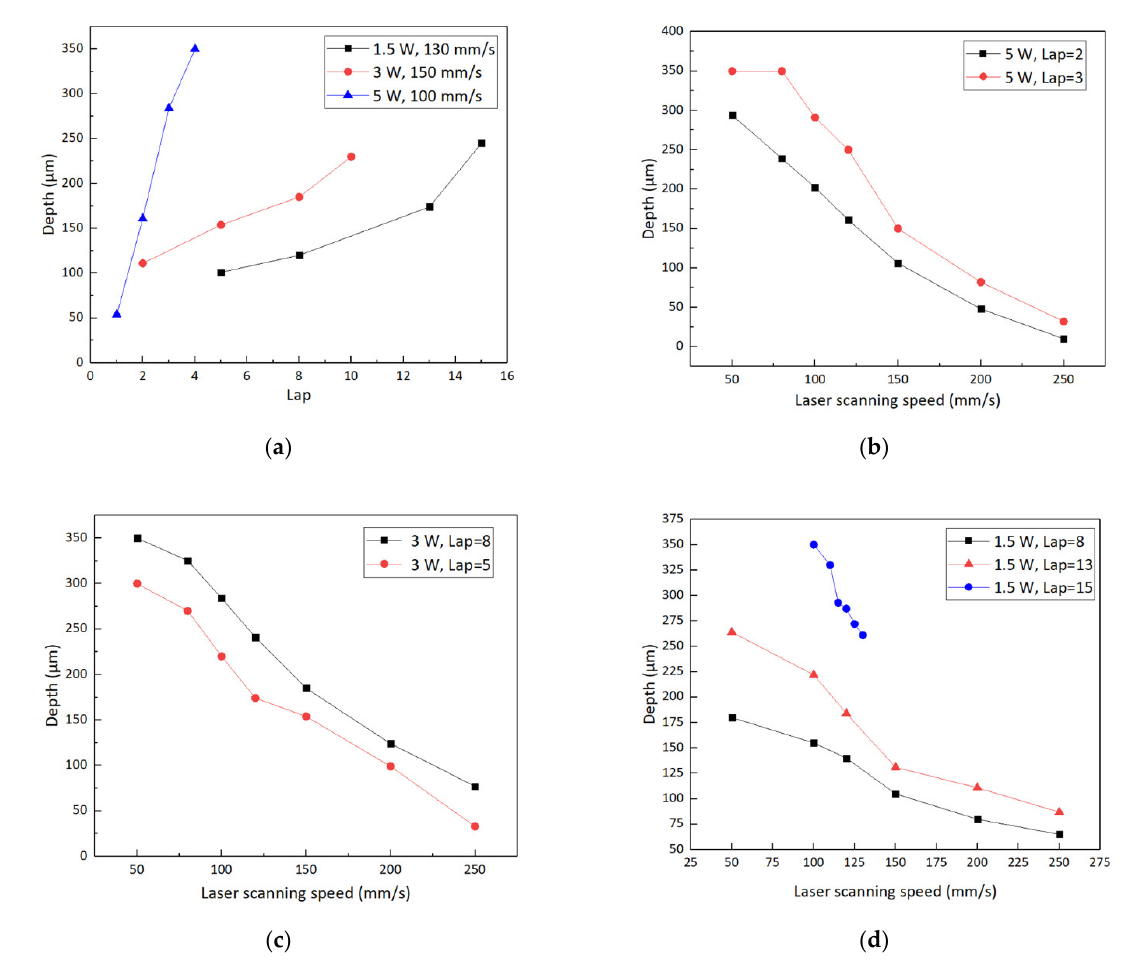
Figure 6. ( a ) Depths of micro blind holes as a function of lap for laser average power of 1.5, 3 and 5 W. Depths of micro blind holes depending on laser scanning speed under different laser average powers and laps: ( b ) laser average power of 5 W, laps of 2 and 3; ( c ) laser average power of 3 W, laps of 5 and 8; ( d ) laser average power of 1.5 W, laps of 8, 13 and 15.